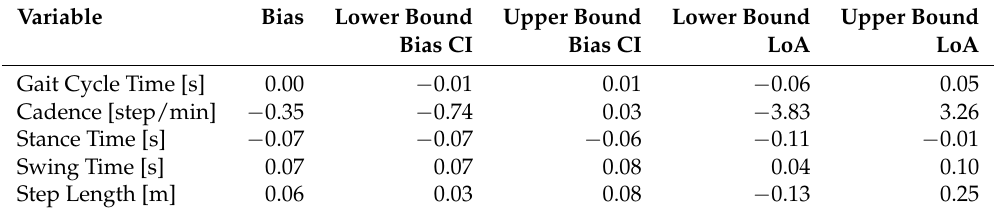
Table 4. Bland–Altman analysis.